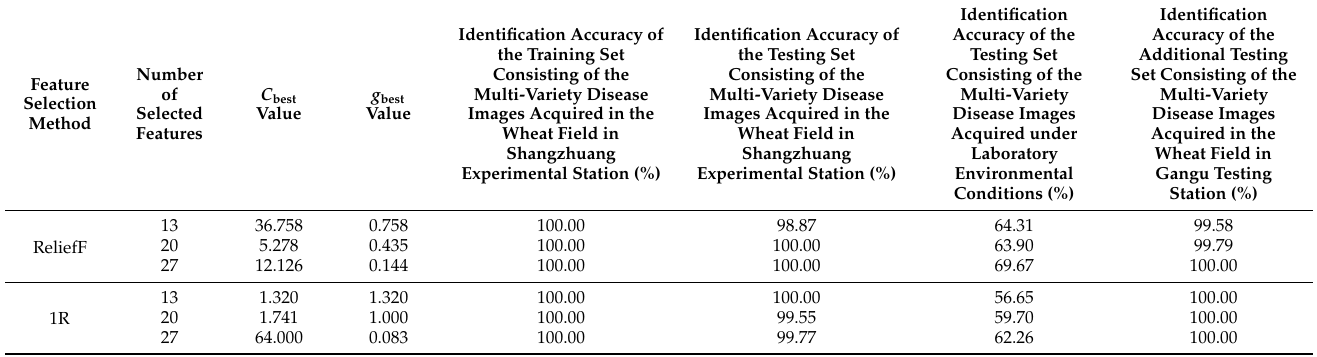
Table 5. Disease identification results of the SVM models built with features selected based on the multi-variety disease image dataset consisting of images acquired in the wheat field in Shangzhuang Experimental Station using feature selection methods including ReliefF and 1R,